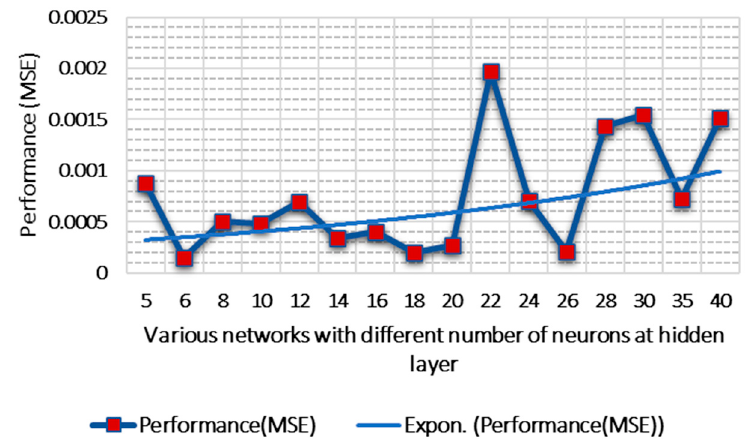
Figure 8. Maximum squared error (MSE) vs. the number of nods in the hidden layer.